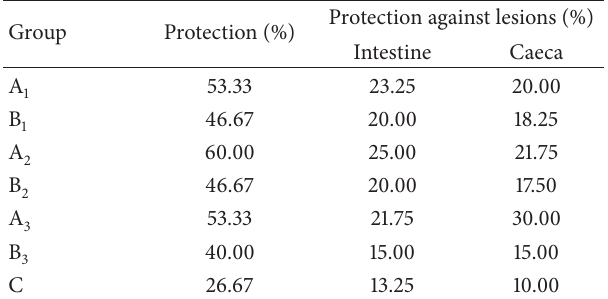
Table 3: Percent protection against mortality and intestinal, caecal lesions in experimental and control chickens.